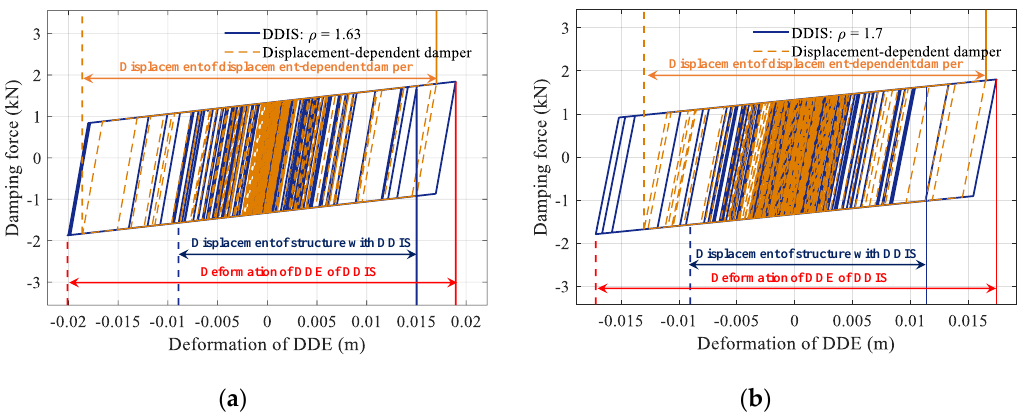
Figure 16. Hysteresis curves of the DDEs of the DDIS and displacement-dependent damper under ( a ) El Centro and ( b ) SS excitation.